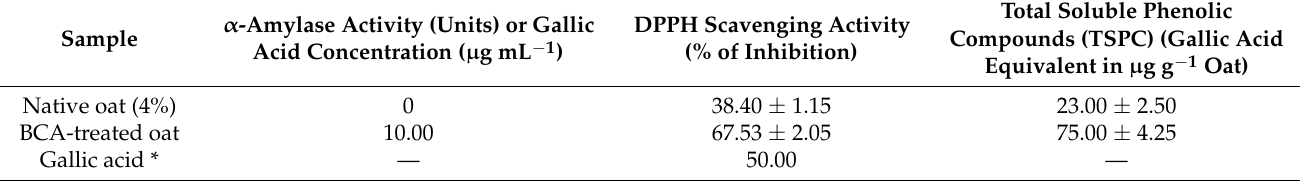
Table 5. Improvement of antioxidant potential of oat flour by purified